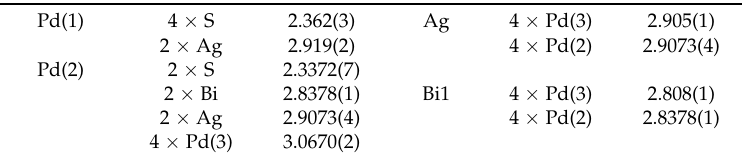
Table 5. Selected bond distances (Å) in the thalhammerite crystal